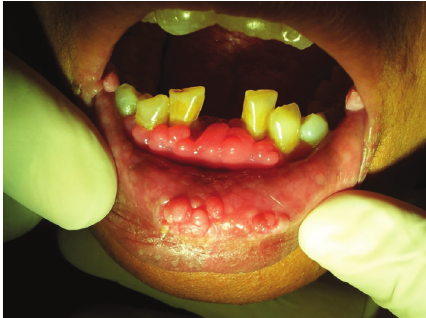
Figure 2: Enlarged gingiva having smooth and multiple papilloma- touslesions.Multiplepapulesmayalsobenoticedonthelowerlabial mucosa.